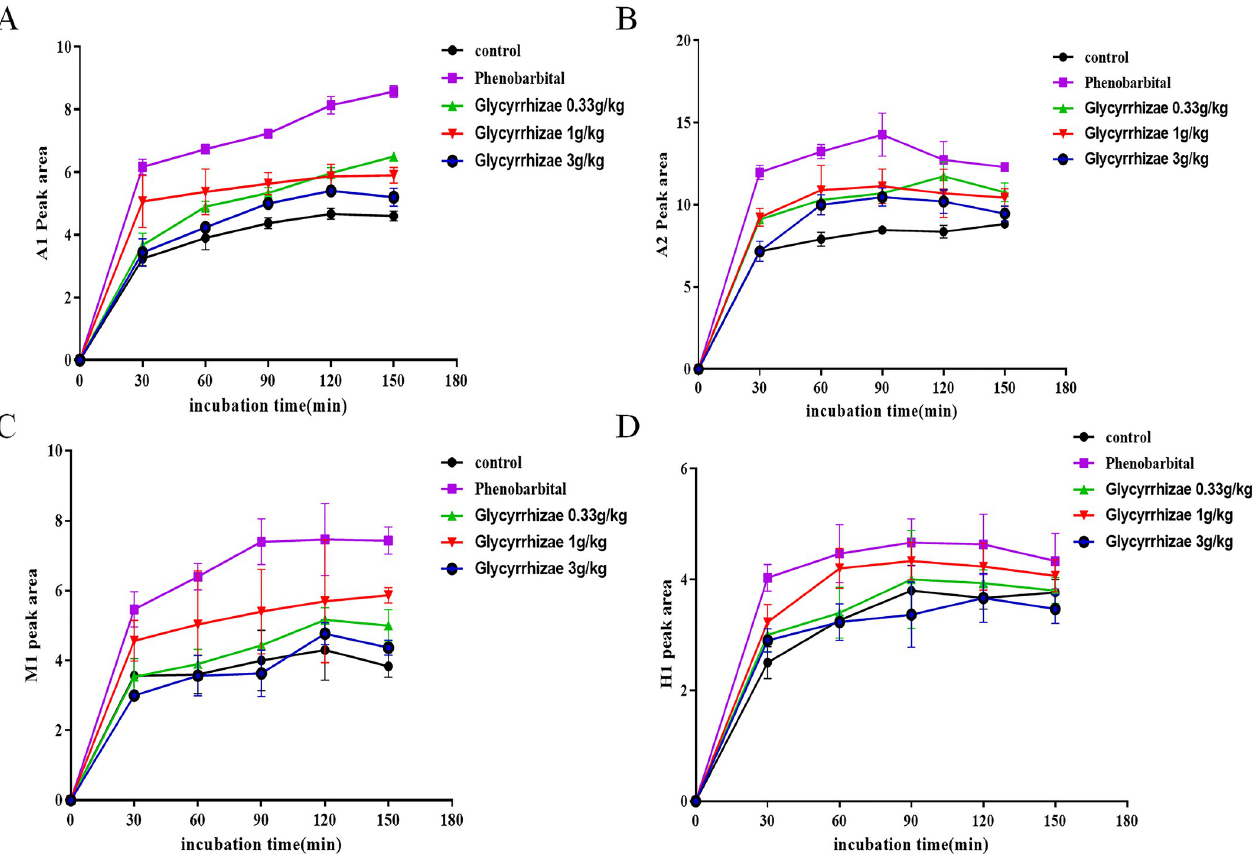
Fig 5. Effects of different concentrations of Glycyrrhiza on the production of toxic metabolites A1, A2, M1 and H1 in Aconitum. Compared with the negative control group, the metabolism rate of AC, MA and HA in Glycyrrhiza low and middle dose groups were significantly increased.